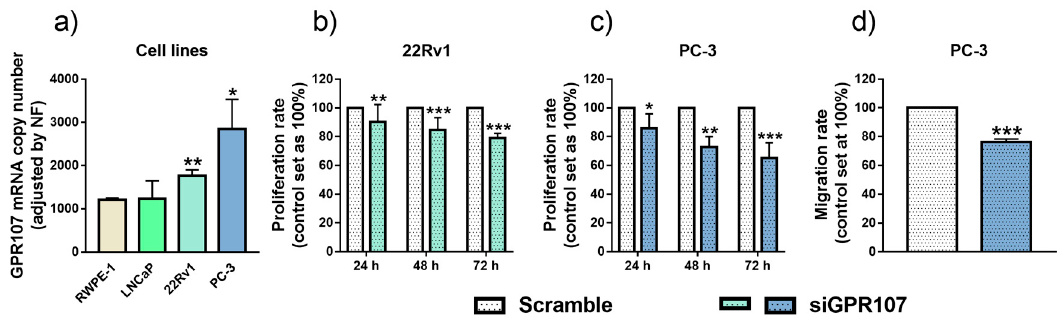
Figure 3. Screening of G protein-coupled receptor 107 (GPR107) expression level and functional e ff ects of its silencing in normal and tumor prostate cell lines. ( a ) Comparison of GPR107 expression levels between a non-tumor prostate cell line (RWPE-1) and di ff erent Prostate Cancer (PCa) cell lines (LNCaP, 22Rv1 and PC-3). Messenger RNA (mRNA) levels were determined by quantitative Polymerase Chain Reaction (qPCR) and adjusted by a normalization factor (NF) generated by the combination of Actin Beta (ACTB) and Glyceraldehyde-3-Phosphate Dehydrogenase (GAPDH) expression levels. ( b) –( c ) Proliferation rate of 22Rv1 ( b ) and PC-3 ( c ) cells after 24, 48 and 72 h of GPR107-silencing. ( d ) Migration rate of PC-3 cells after 24 h of GPR107-silencing. In ( b )–( d ), data were represented as percent of scrambled cells (set at 100%). Asterisks (* p < 0.05; ** p < 0.01; *** p < 0.001) indicate statistically significant di ff erences between groups. siGPR107: small interferent RNA against GPR107.